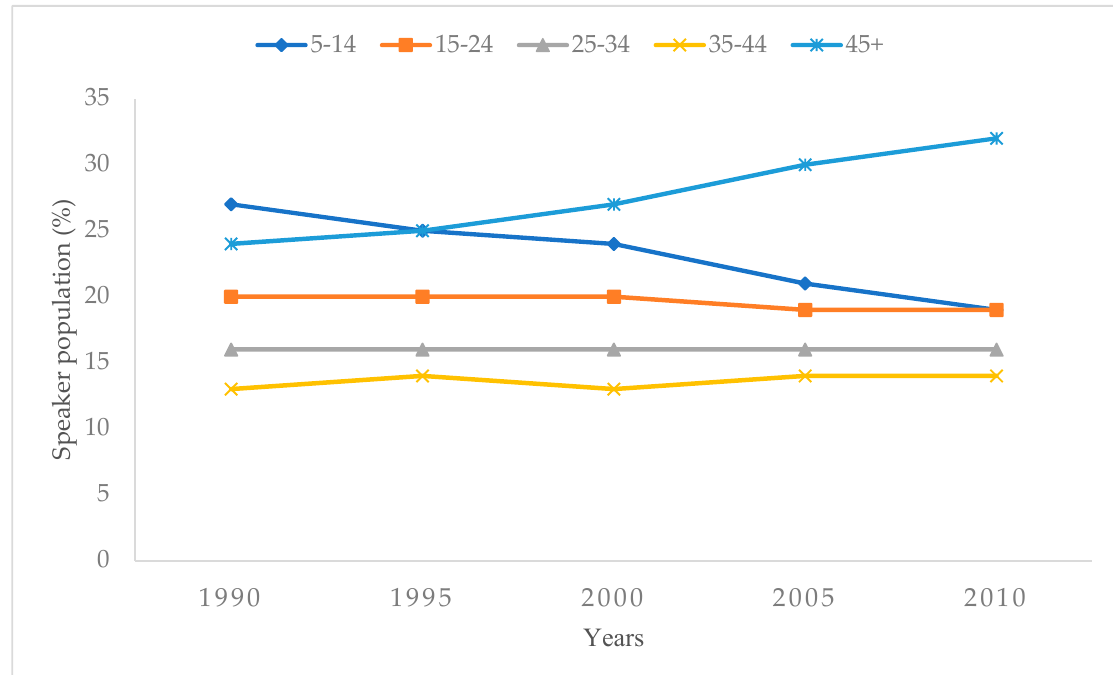
Figure 1. Distribution of the Nahuatl-speaking population by age group (1990–2010) (%). The absolute number of Nahuatl speakers was 1,197,328 (in 1990), 1,325,440 (in 1995), 1,448,936 (in 2000), 1,376,026 (in 2005) and 1,544,968 (in 2010). Sources: General Census (INEGI 1990, 2000, 2010b) and Population and Housing Census (INEGI 1995, 2005).